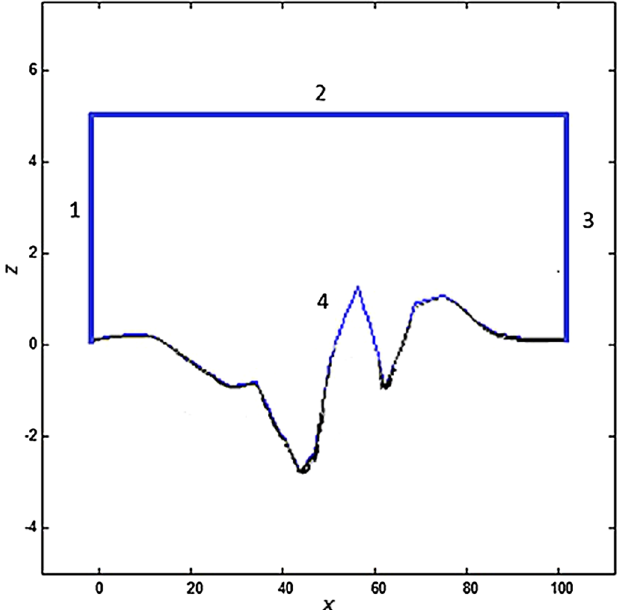
FIG. 2. Configuration used for the simulation model calculation on a cross-section fragment of a BCP-treated sample surface. The area bounded in blue represents vacuum volume. Borderlines 1 and 3 determine the exciting magnetic field. Borderline 2 and 4 are perfect electric conductors (PEC), while border 4 outlines a BCP-treated surface profile, also PEC, acquired by AFM scanning. Unit: μ